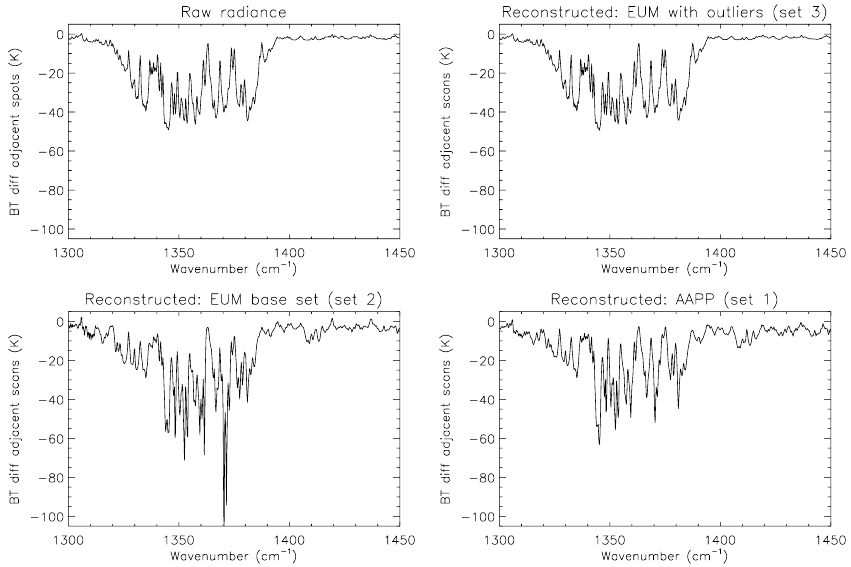
Fig. 6. Difference spectra between a spot on the north-eastern edge of the Kasatochi plume and a spot on the previous IASI scan line which is outside the plume. The ν 3 band of SO 2 covers the range 1320 to 1400cm − 1